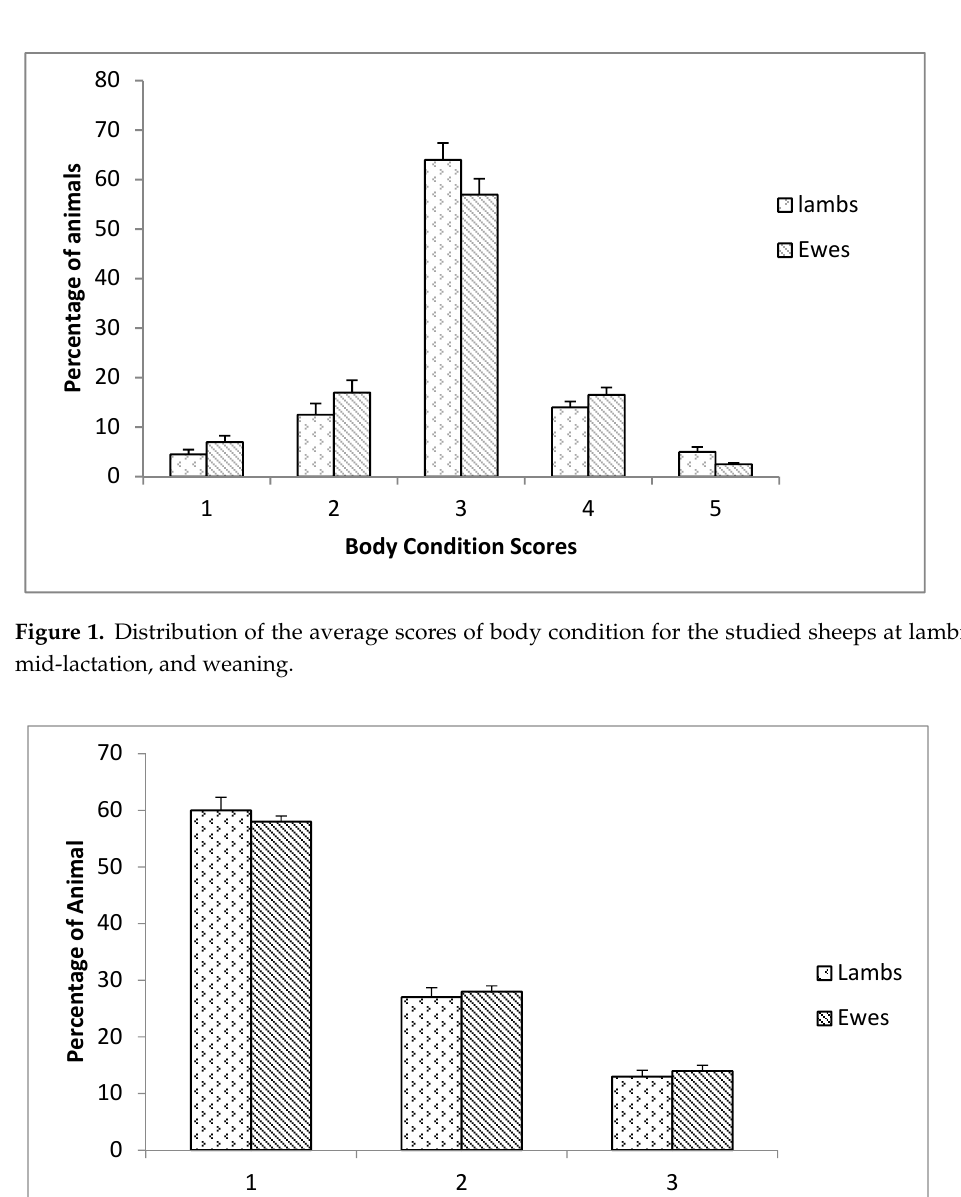
Figure 2. Distrubition of the average of scores of cleanliness for the studied sheeps at lambing, mid-lactation, and weaning.